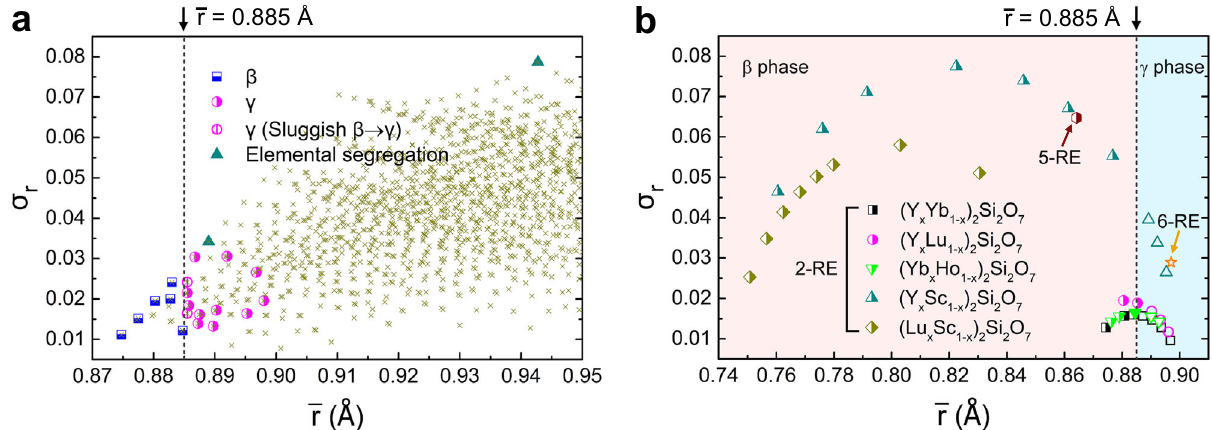
-- r ) and the deviations ( σ r ) for ( n RE xi ) Fig. 4 | The average RE 3+ radius ( according to the works of ref. 31,41 – 47 . The red hexagon mark and the orange star 2 Si 2 O 7 compounds. a The (cid:1) r versus σ r diagram for (RE I 0.25 RE II 0.25 RE III 0.25 RE IV 0.25 ) 2 Si 2 O 7 represent the data for (Yb 0.2 Y 0.2 Lu 0.2 Sc 0.2 Gd 0.2 ) 2 Si 2 O 7 and (Gd 1/6 Tb 1/6 Dy 1/6 Tm 1/ “ 2-RE ” , “ 5-RE ” and “ 6-RE ” represent compositions. The crosses represent the calculated (cid:1) r and σ r parameters for all the 6 Yb 1/6 Lu 1/6 ) 2 Si 2 O 7 compounds,respectively;and possible RE I 0.25 RE II 0.25 RE III 0.25 RE IV 0.25 combinations, wherein RE elements varies the two-, fi ve- and six-RE-principal-component disilicates. The β - γ boundary at (cid:1) r ~0.885Å is marked in dash lines for from the lanthanides (La~Lu) and Y elements. b The (cid:1) r versus σ r diagram for some equimolar or non-equimolar ( n RE xi ) 2 Si 2 O 7 ( n =2, 5 and 6; 0 ≤ x i ≤ 1) materials,